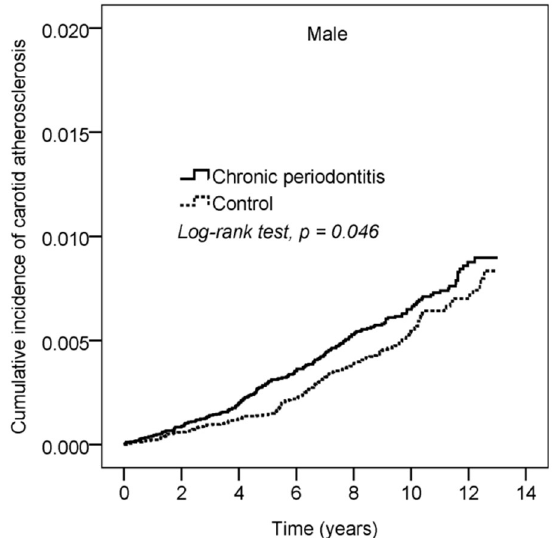
Figure 2. Cumulative incidence of carotid atherosclerosis (CA) in chronic periodontitis (CP) and control groups.